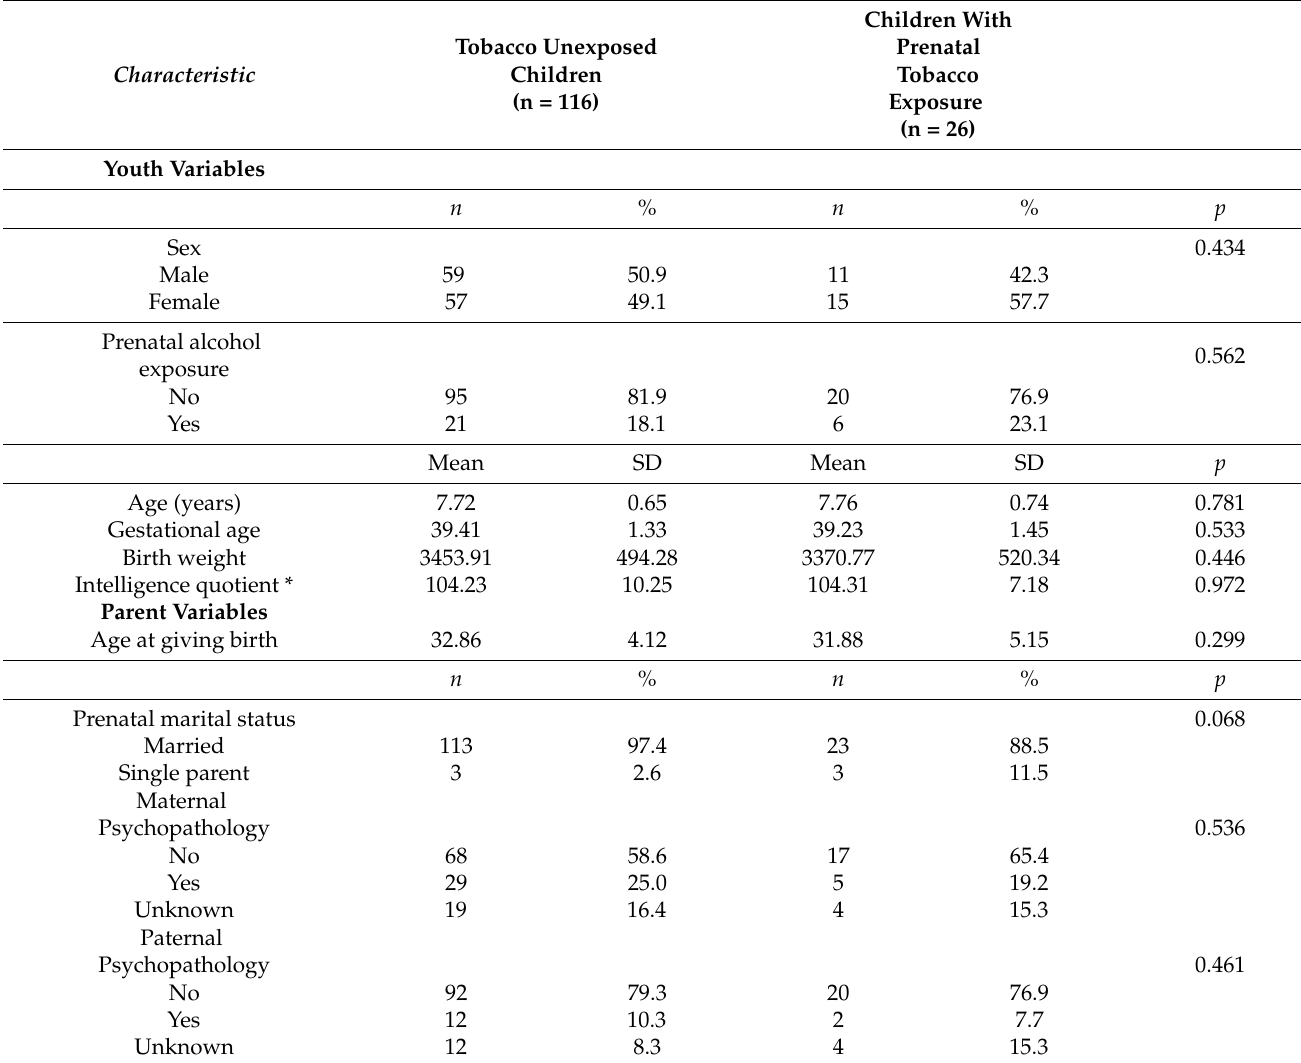
Table 1. Sample characteristics with children divided into two groups of the tobacco non-exposed and prenatal tobacco-exposed